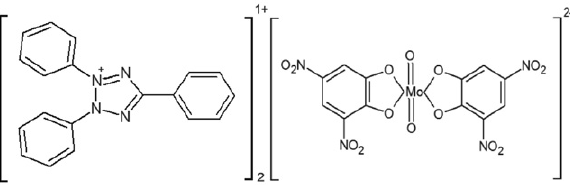
Figure 8. Structural formula of the ion-associated complex